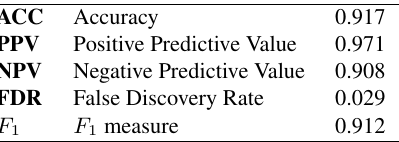
Table 1: Window Detection